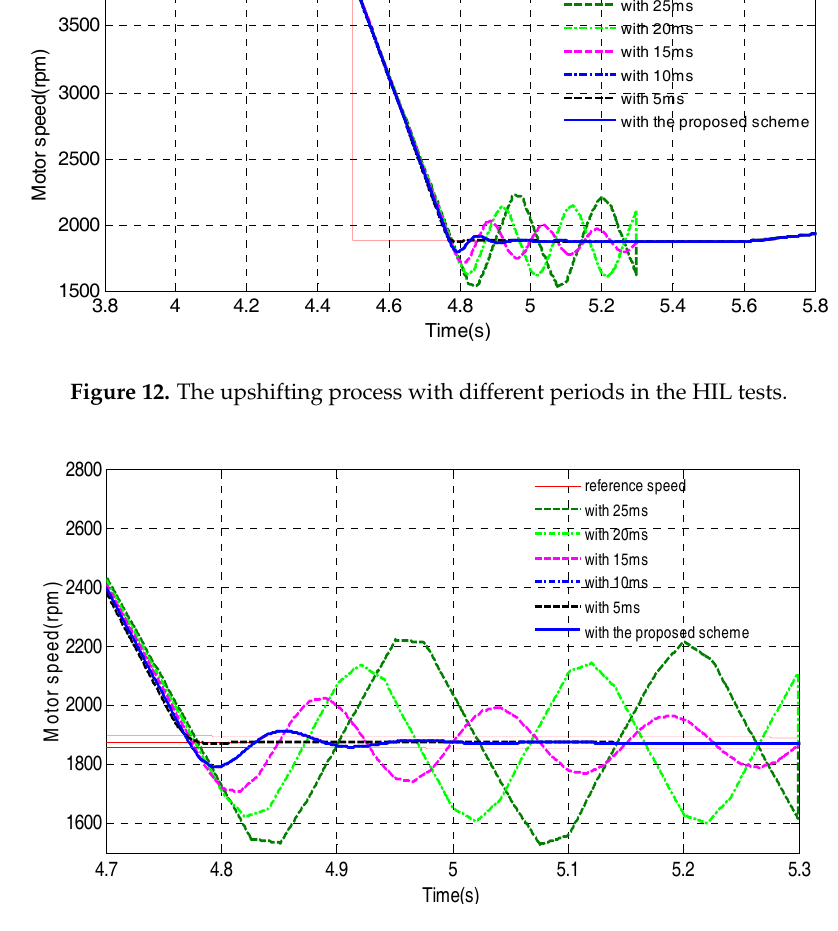
Figure 13. The speed synchronization responses in detail in the HIL tests.